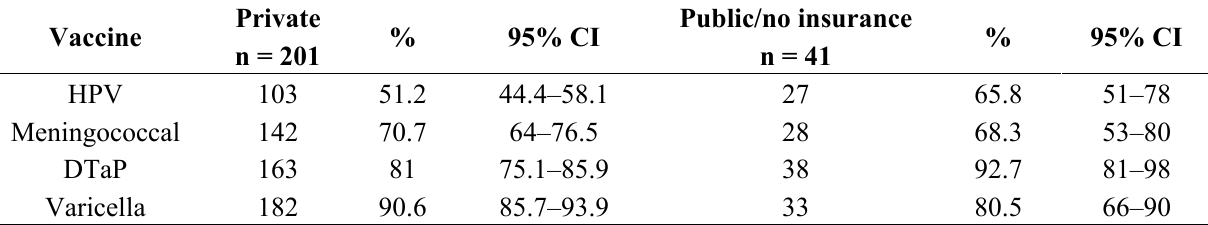
Table S3. Supplemental data for Figure 3.